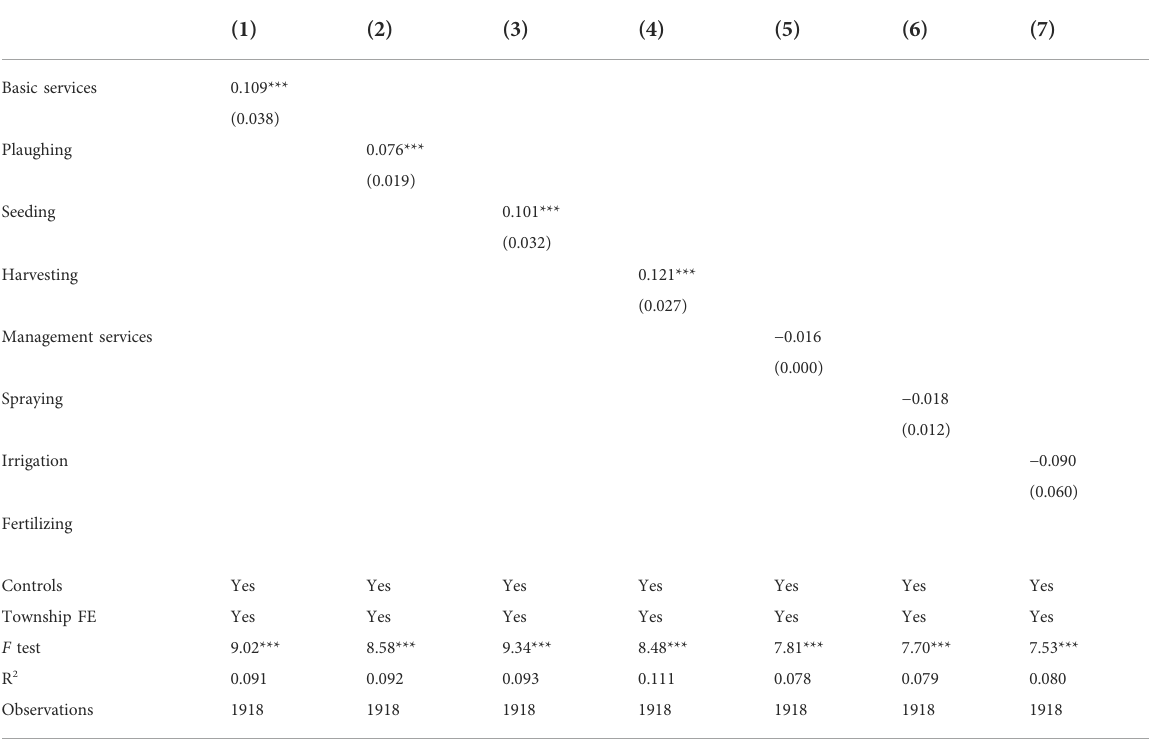
TABLE 3 OLS regression for the effect of AMS on cultivated land productivity by planting activity. Dependent variable: Cultivated land